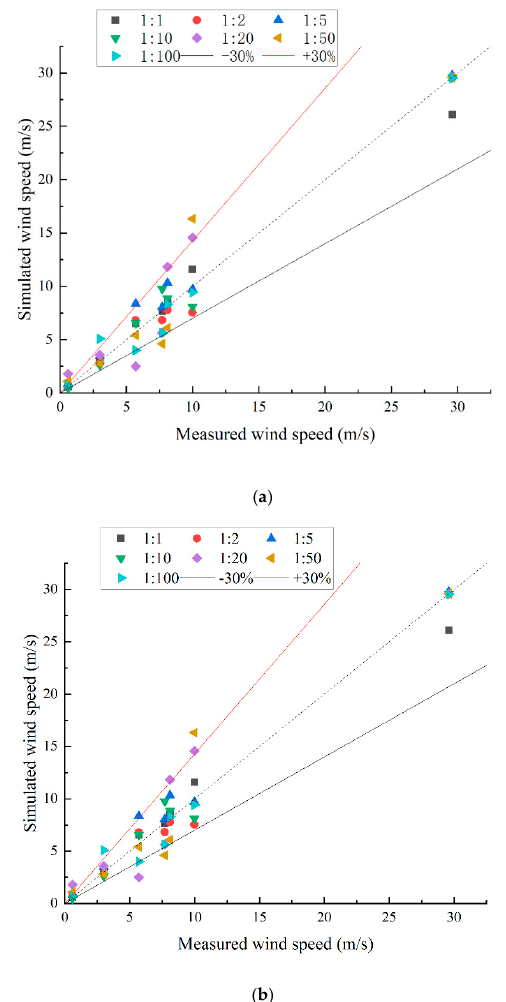
Figure 15. Comparison of simulated wind speed ( a ) and rainfall intensity ( b ) with prototype obser- vations under the condition of similar atmospheric pressure. Figure 15 shows the comparison between the predicted value of the calculation model of different geometric scales and the observed value of the prototype. Under the condition of similar atmospheric pressure, the deviation between the atomization wind speed obtained by the geometric models with different scales and the measured wind speed is smaller than that of the models that did not meet similar atmospheric pressure, and the deviation between the predicted value of the model and the measured value is ±30%. After considering similar atmospheric pressure conditions, the prediction accuracy